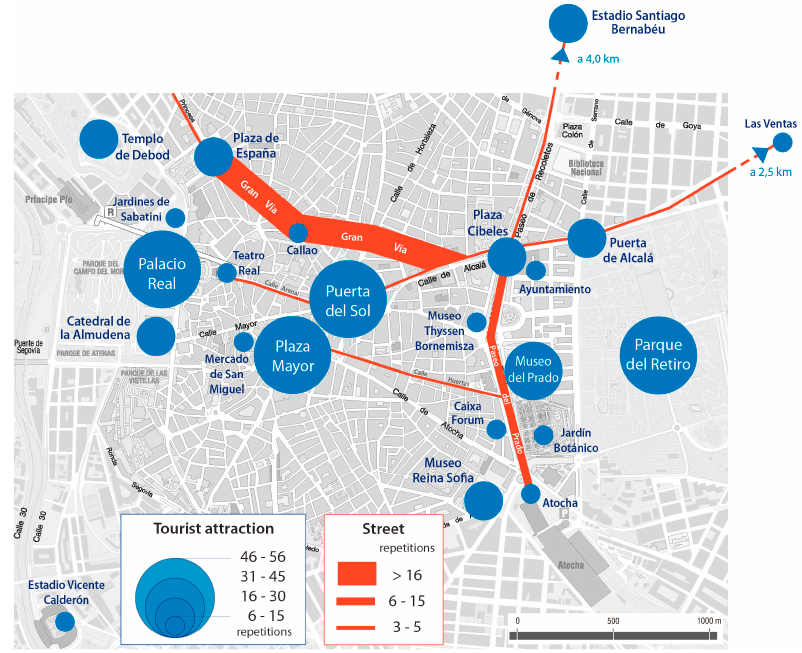
Figure 4. Collective conception of Madrid, with the features most frequently identified by tourists.